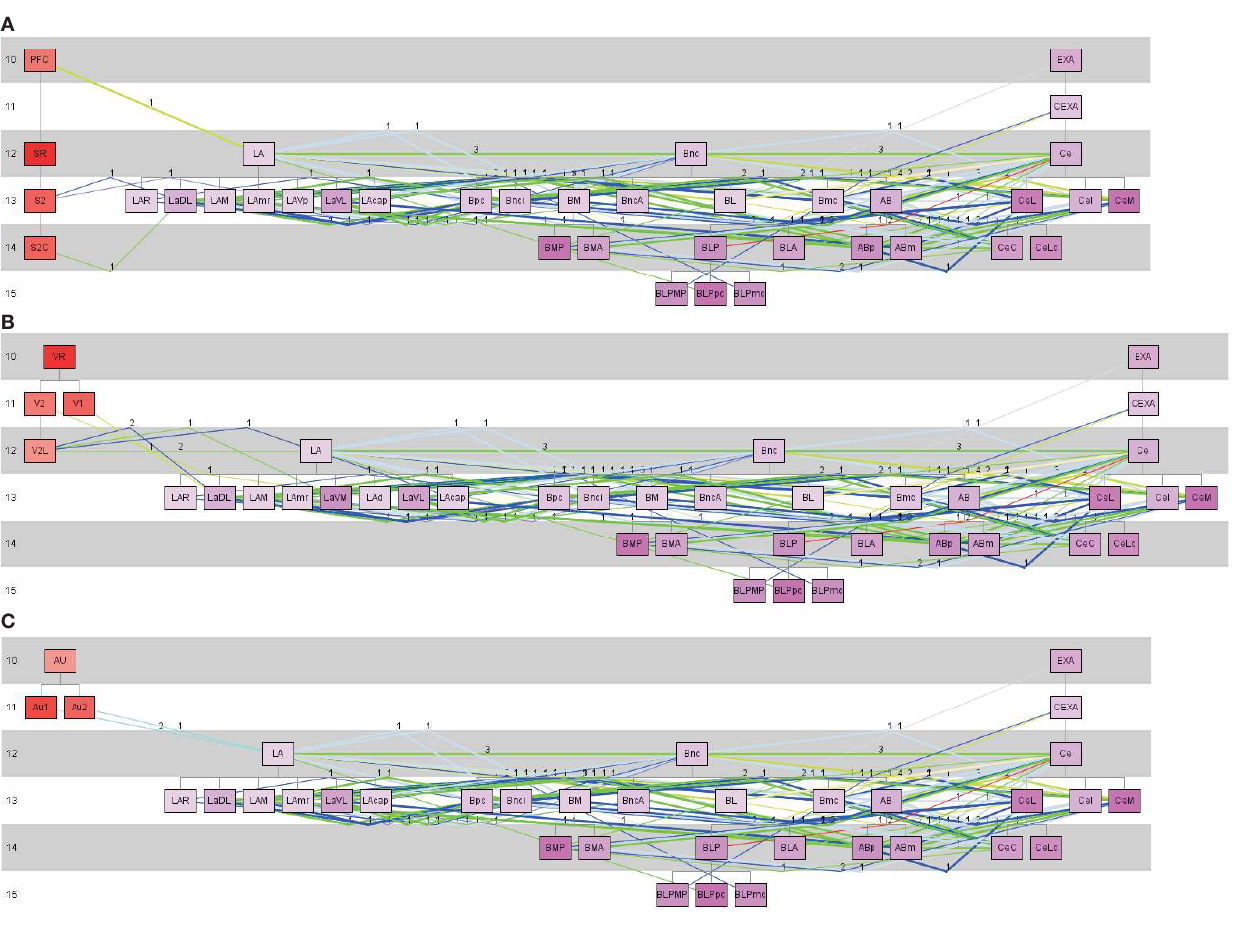
FIGURE 8 | Pathway analysis of somatosensory, visual and auditory regions of the cerebral cortex and the lateral, basal, and central nuclear complexes of the amygdala. (A) Somatosensory, (B) visual, and (C) auditory cortical regions are defined as source regions of the projection to the lateral (LA) nuclear complex of the amygdala. All subregions of the LA are taken into account as putative target regions. From these LA-target regions connections to the basal nuclear complex (including BL) where searched. From the basal nuclear complex,